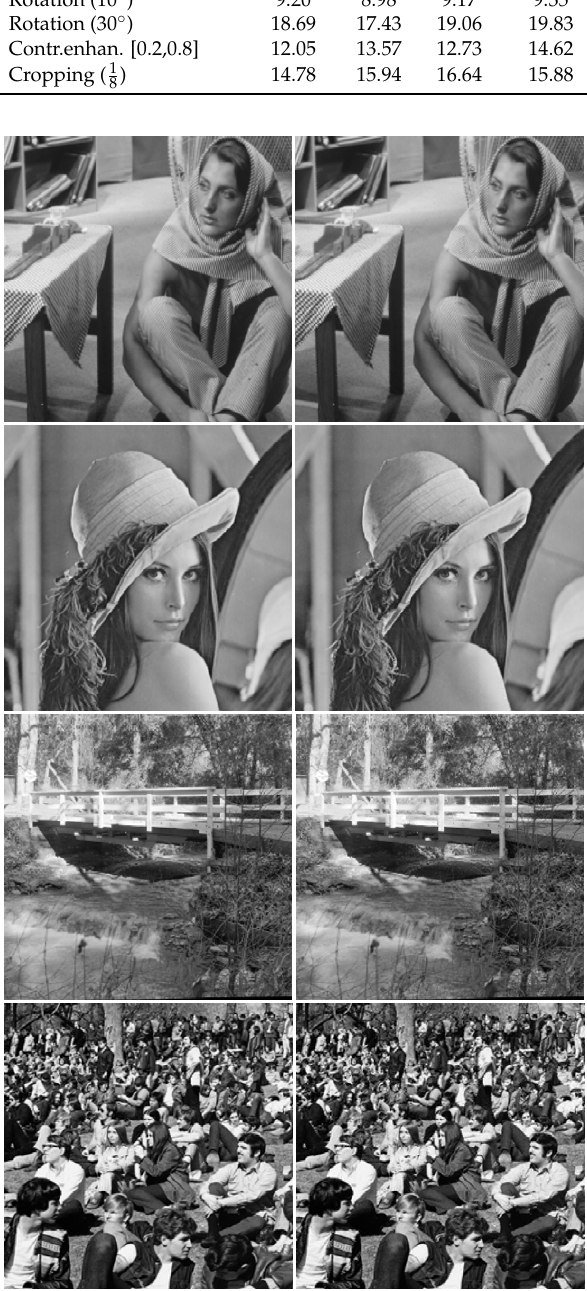
Figure 3. Original and watermarked